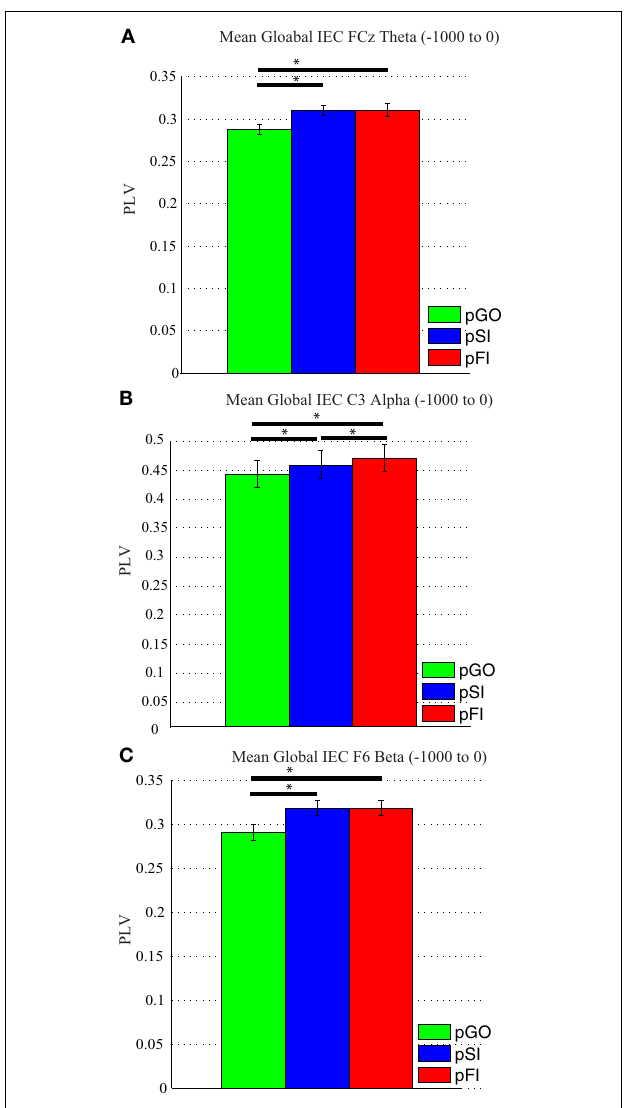
FIGURE 3 | Mean global inter-electrode coherence (IEC) over the − 1000 to 0ms interval. (A) Mean theta IEC from the FCz electrode to all other electrodes. (B) Mean alpha IEC from the C3 electrode to all other electrodes. (C) Mean beta IEC from the F6 electrode to all other electrodes. ∗ p < 0 .